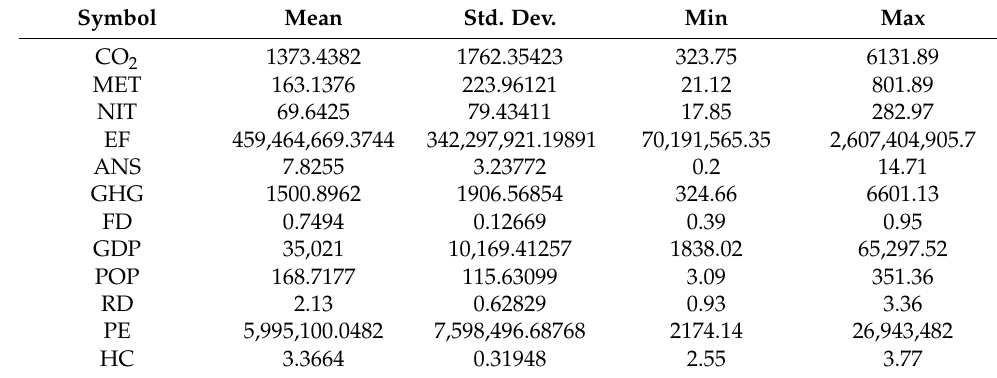
Table 3. Descriptive